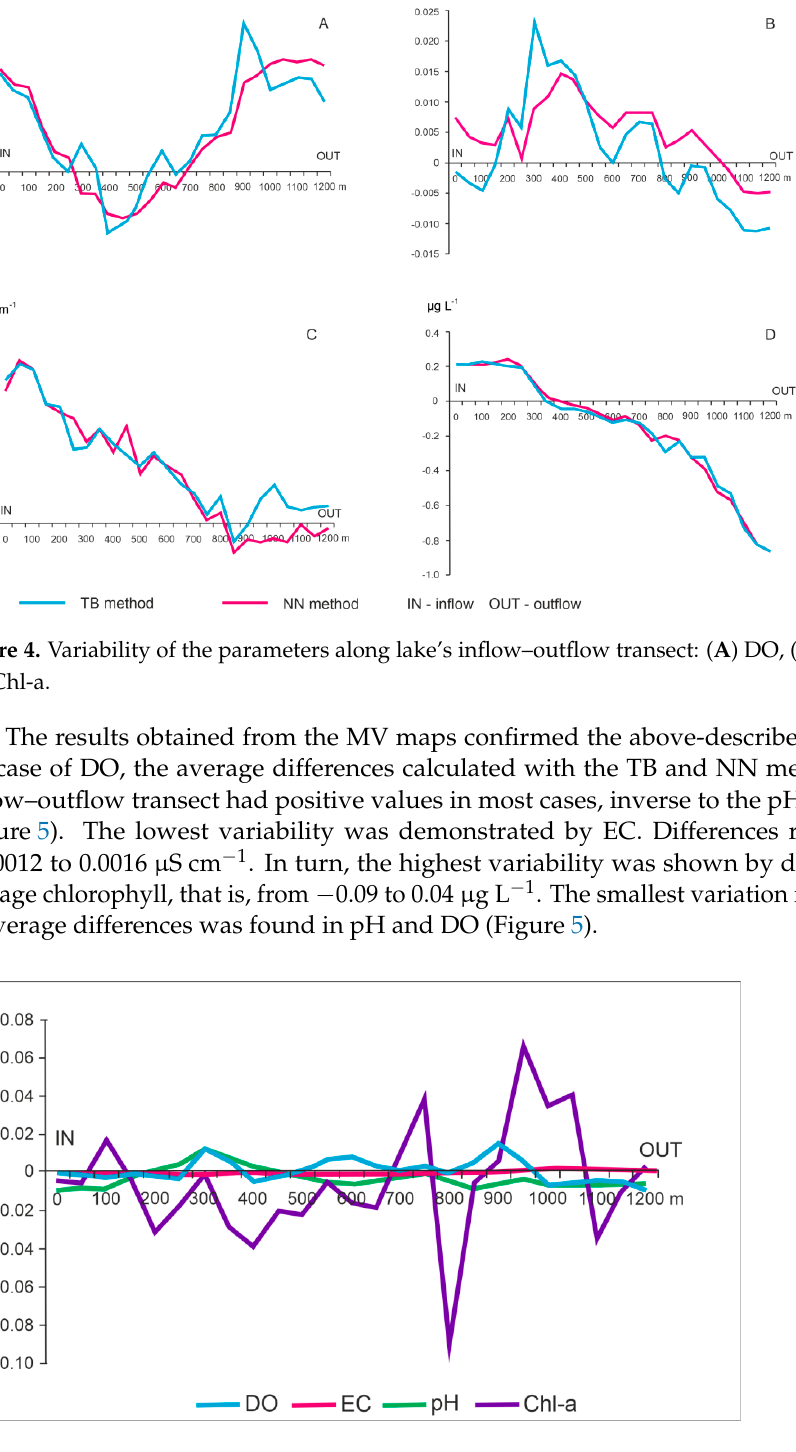
Figure 5. Differences (based on MV maps) between TB and NN values calculated for the selected